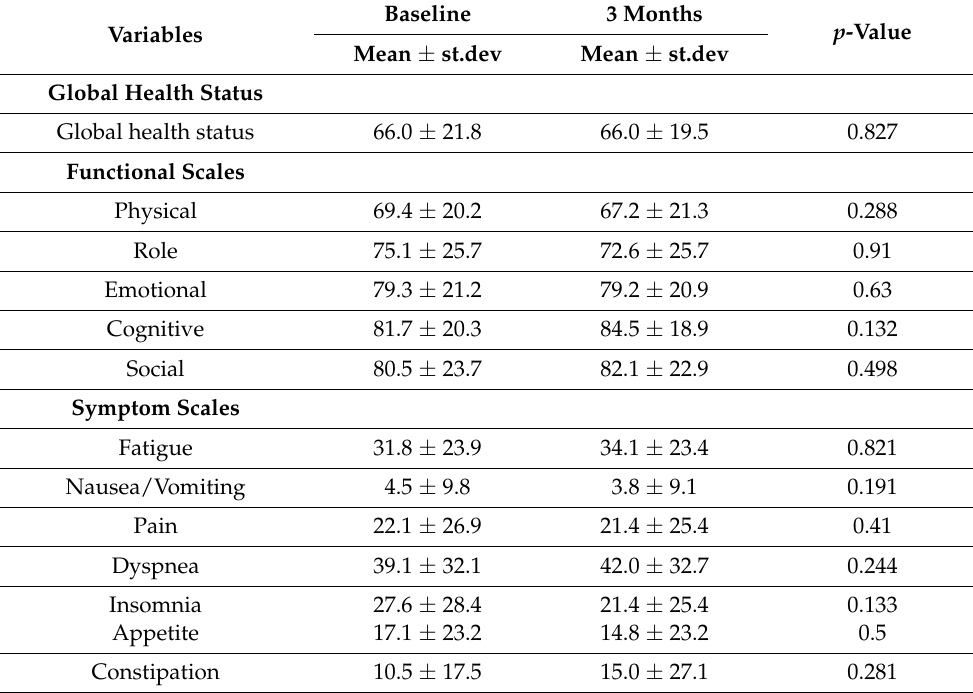
Table 2. Health-related quality-of-life